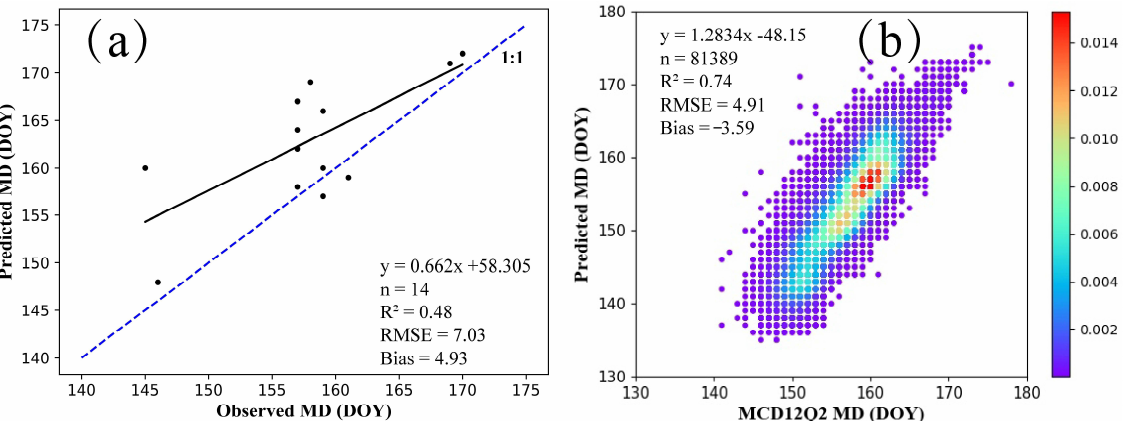
Figure 7. The validation of predicted MD of winter wheat by ( a ) ground observed data and ( b ) MCD12Q2 data.